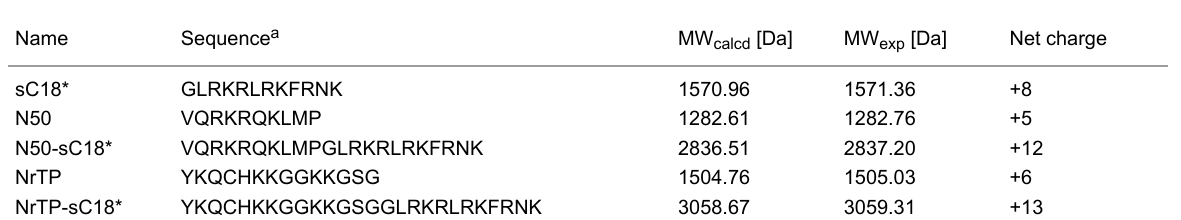
Table 1: Names, sequences, molecular weights and net charges of the peptides that were investigated in this study. All peptides were obtained in >99% purity.